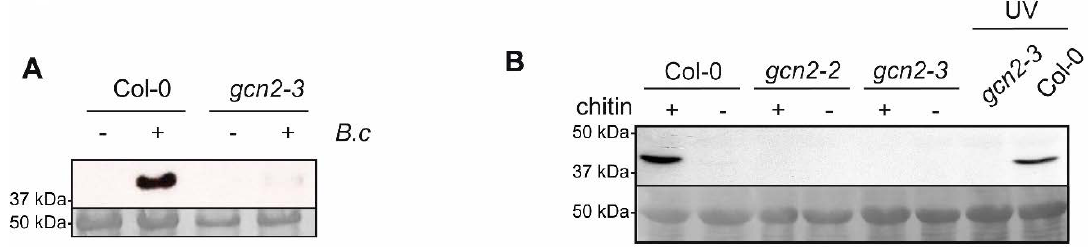
Figure 2. GCN2-dependent eIF2 α phosphorylation is induced upon contact with B. cinerea spores and by chitin. ( A ) Analysis of eIF2 α -P of wild-type (Col-0) and gcn2-3 (SALKseq_129334) seedlings mock inoculated (-) or incubated with a suspension of 5 × 10 6 spores / mL of Botrytis cinerea (B.c) ( + ) for 60 min. ( B ) Analysis of eIF2 α phosphorylation of wild-type (Col-0), gcn2-2 (SALKseq_032196) and gcn2-3 (SALKseq_129334) seedlings incubated in the presence of 400 mg / L chitin ( + ) or in the absence of chitin ( − ) for 1 h. As control, Col-0 seedlings were subjected to an UV treatment known to promote eIF2 α phosphorylation. In all cases, 7-day-old seedlings were used for the experiments and eIF2 α phosphorylation was analyzed by Western blot (upper panels). As loading control of each experiment, representative bands from the Coomassie staining of the original membrane are provided (lower panels). All the experiments were independently repeated at least three times obtaining similar results.